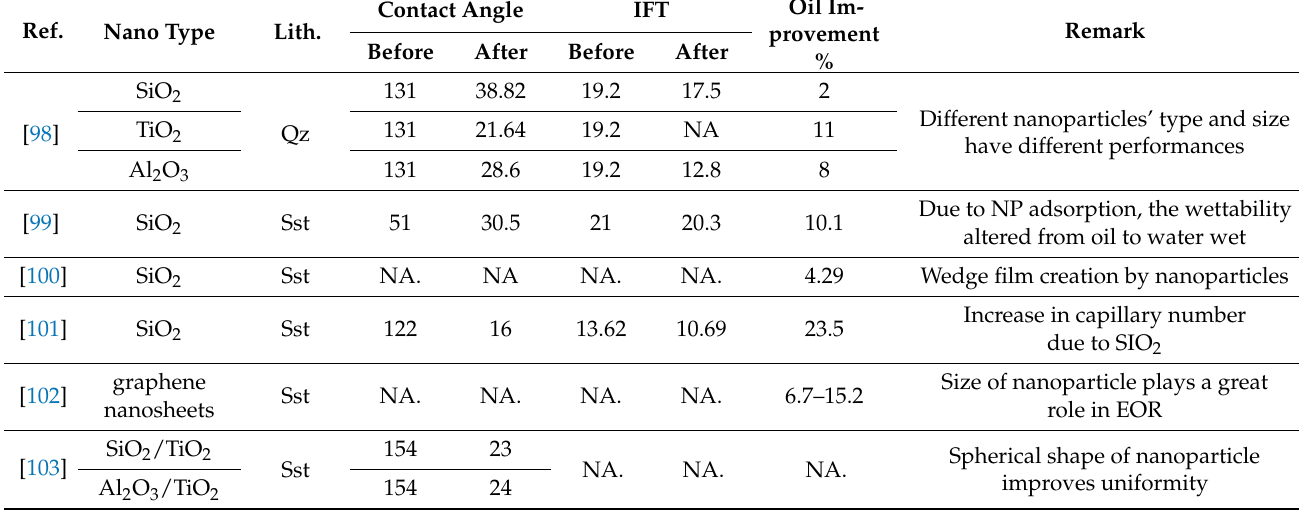
Table 5. Summary of nano, nano-surfactant, nano-polymer and nano-SP flooding. It is concluded that a combination of nanoparticle and nanocomposites with conventional CEOR methods improves the synergism effect. As shown in the summary table, nanoparticles are used to support alkaline and surfactant in IFT reduction and wettability modifications (microscopic improvement). In addition, it is used to lower surfactant costs through controlling surfactant adsorption on the rock surface. In the case of polymers, nanoparticles improve the mobility of the polymeric solution, resulting in better oil sweep efficiency and reducing breakthrough time (macroscopic improvement). Lith = Lithology; Sst = Sandstone; Carbo. = Carbonate; Qz = Quartz.